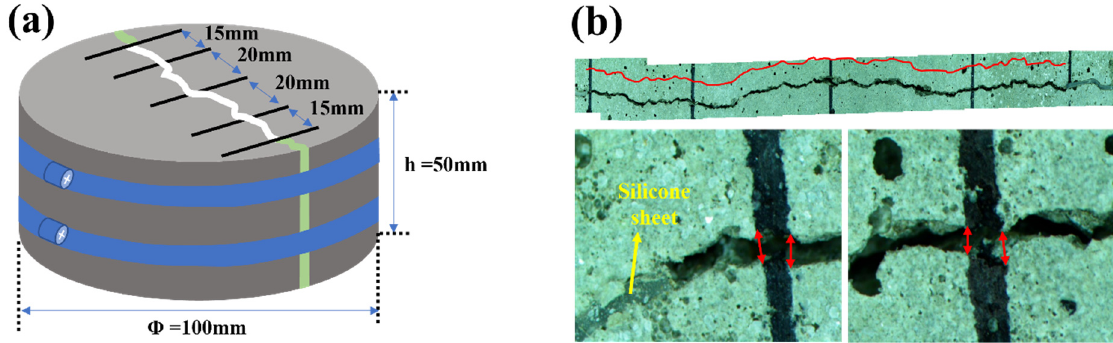
Figure 2. Crack-induced specimen for water permeability test: ( a ) schematic of the crack-induced specimen; ( b ) example of representative length and crack measurement of specimen.